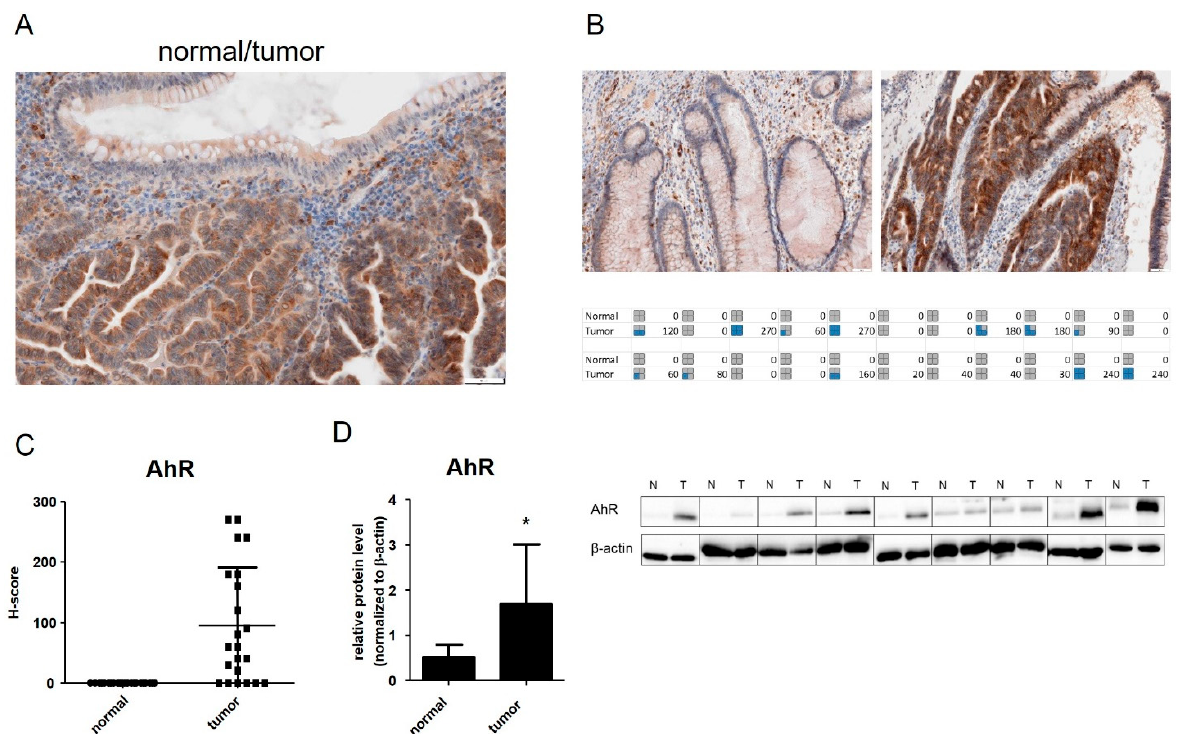
Figure 1. AhR protein levels are increased in human colon cancer tissue. ( A ) A representative image of AhR staining in colon tumor; ( B ) a comparison of AhR staining between normal (left) and tumor (right) colon tissue. H-scores were calculated based on intensity and positivity values. Pictograms at the bottom of the panel document staining of all formalin-fixed paraffin-embedded tissue specimens (n = 22; grey, H-score 0–59; blue, H-score in quartiles up to 119, 179, 239 and 300); ( C ) H-score values comparing AhR staining in normal and tumor tissue. ( D ) AhR protein levels were determined by Western blotting in representative samples of isolated tumor and non-tumor colon epithelial cells (n = 10), using anti-human AhR rabbit monoclonal antibody, with β -actin being used as loading control. Representative Western blotting images are shown at the right. For original blots, see Supplementary File S1. Relative AhR levels determined by densitometry and normalized to -actin are shown at the left. * denotes a significant difference ( p < 0.05) between AhR protein levels in tumor and non-tumor cells.